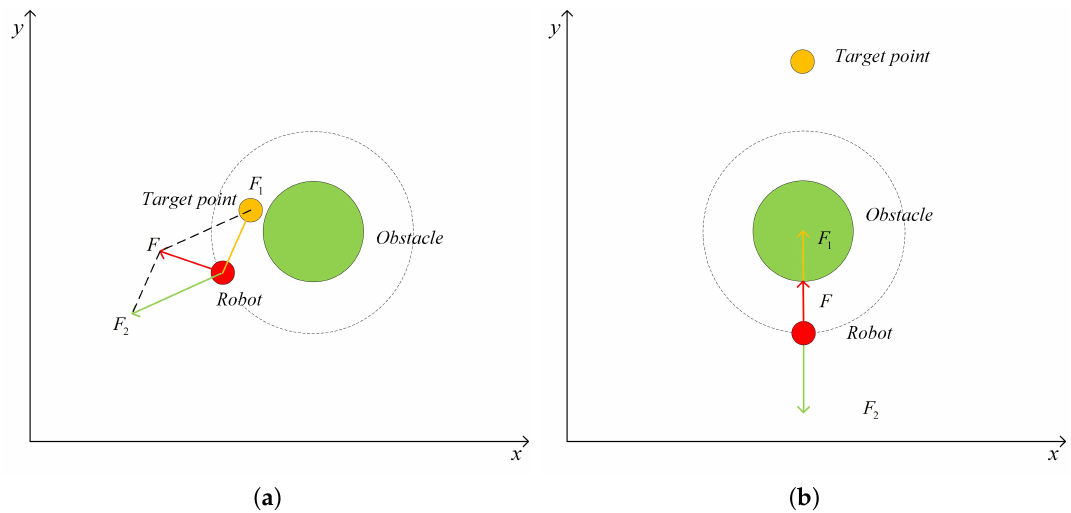
Figure 2. Problems of a traditional artificial potential field (APF): ( a ) unreachable goals with obstacles nearby (GNRON) and ( b ) trapped in a local minimum